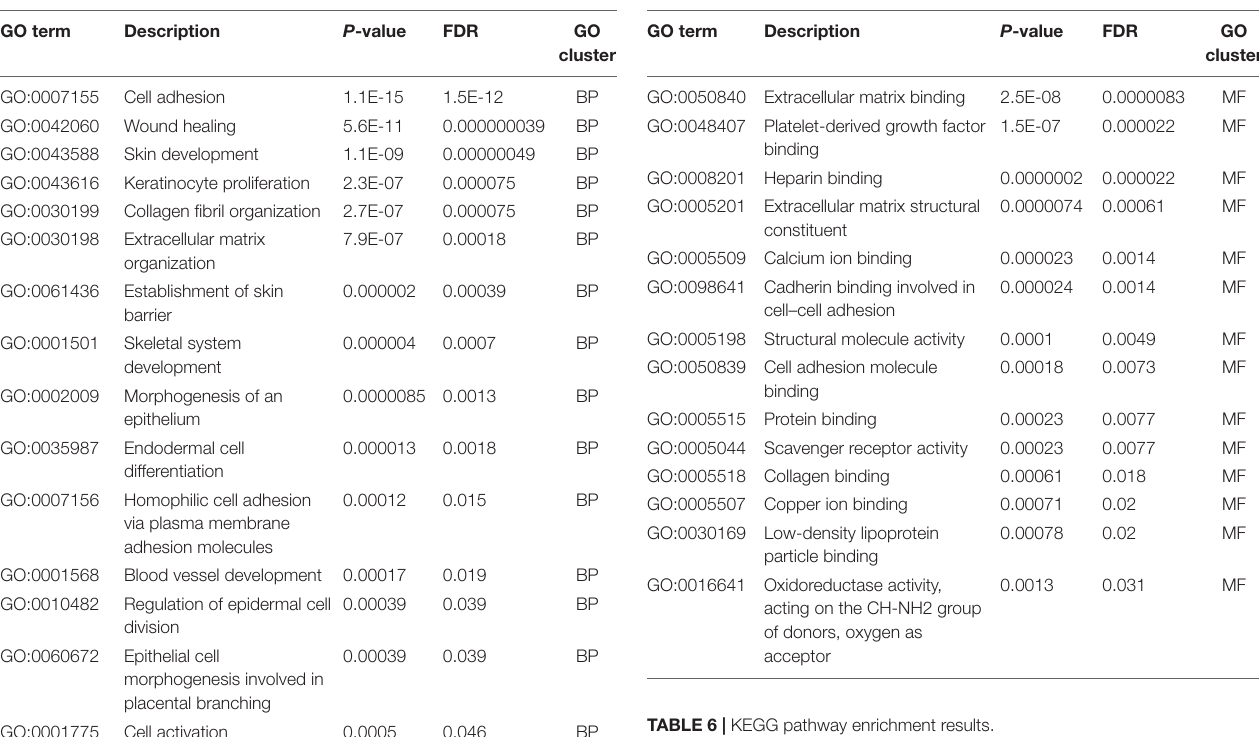
TABLE 5 | Gene ontology enrichment results, molecular functions (MF).